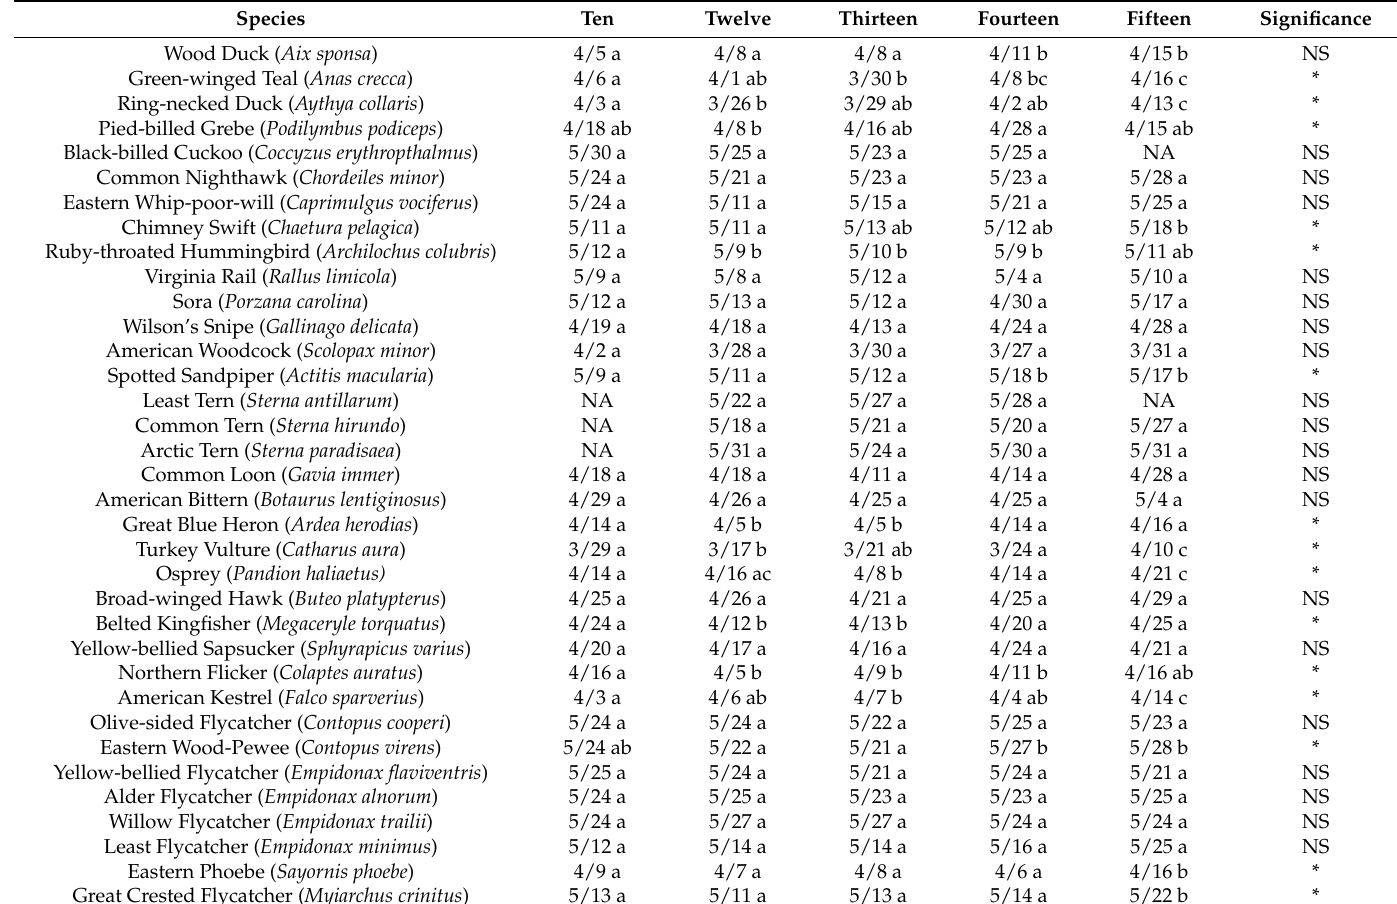
Table 2. Comparison of mean arrival dates in the five best sampled Biophysical Regions (see Table 1). Benjamini-Hochberg corrections were used to adjust for false discovery rates because of multiple comparisons [17]. Asterisks indicate significant differences ( p < 0.05) after correction. Dates with the same letter are not significantly different from each other in Tukey Honest Significant Difference pair-wise tests. Species order follows the North American Classification Committee Checklist of North American Birds